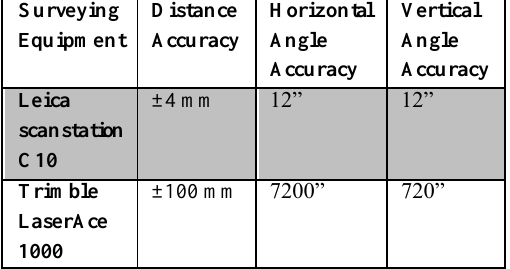
Table 2: Coefficient of unknowns including rotation, scale and translation parameters (matrix A). R X Y coefficien coefficien t